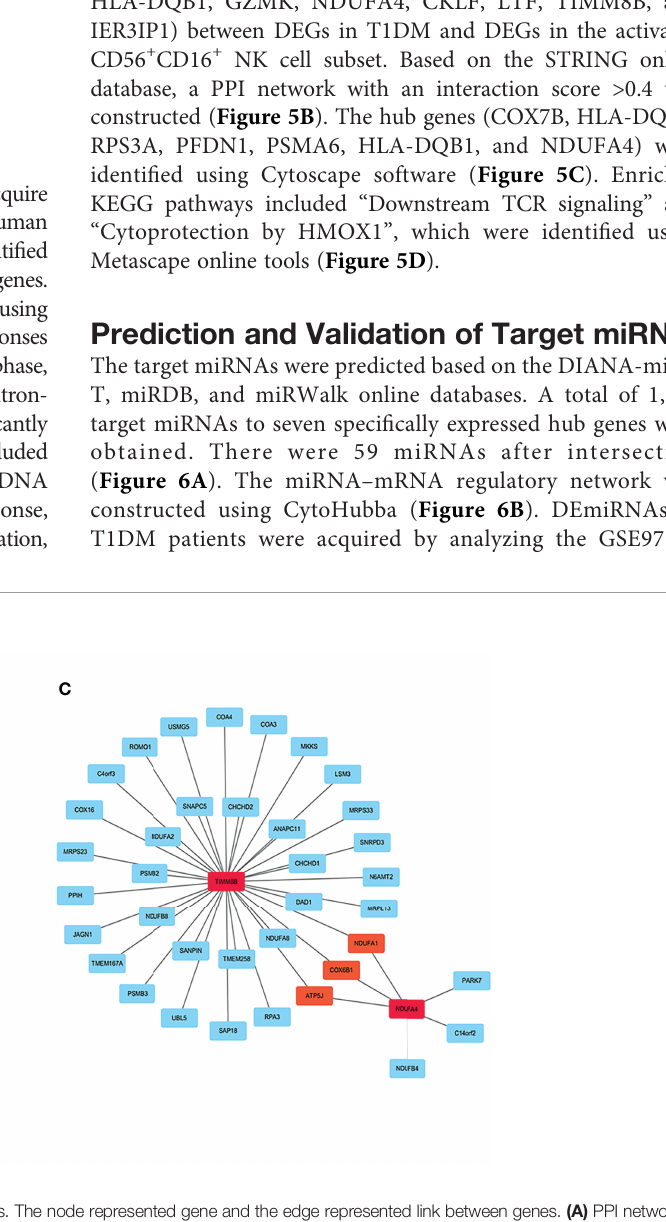
FIGURE 3 | PPI network analysis of DEGs in T1DM ketosis or ketoacidosis. The node represented gene and the edge represented link between genes. (A) PPI network of differentially expression genes in T1DM ketosis or ketoacidosis. (B) Cytoscape network clustering visualization of hub DEGs in T1DM ketosis or ketoacidosis samples. The node represented gene and the edge represented link between genes. The red/orange/yellow color meant the MMC score was highest/moderate high/mild high. (C) The mature NK cell-speci fi c gene co-expression network for DEGs in T1DM ketosis or